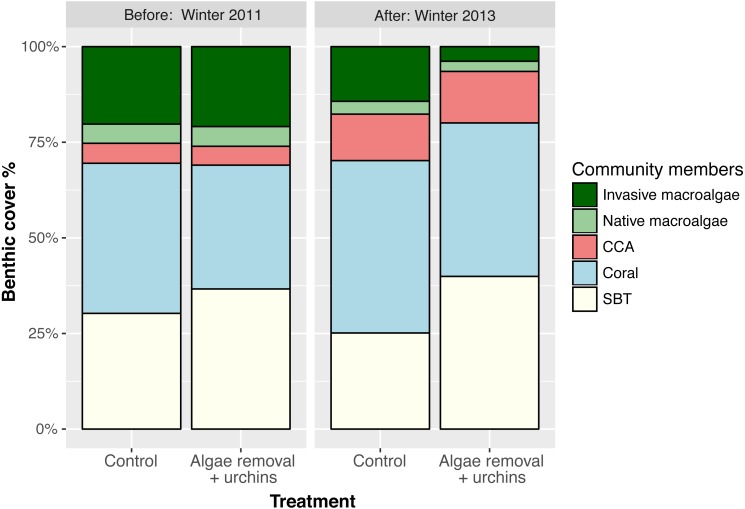
Mean percent cover for benthic community members at control and treatment reefs before applying treatments (Winter 2011) and two years after treatment application (Winter 2013).Values are mean ± SE; n = 24 (control) and n = 26–27 (treatment) for each sampling time.